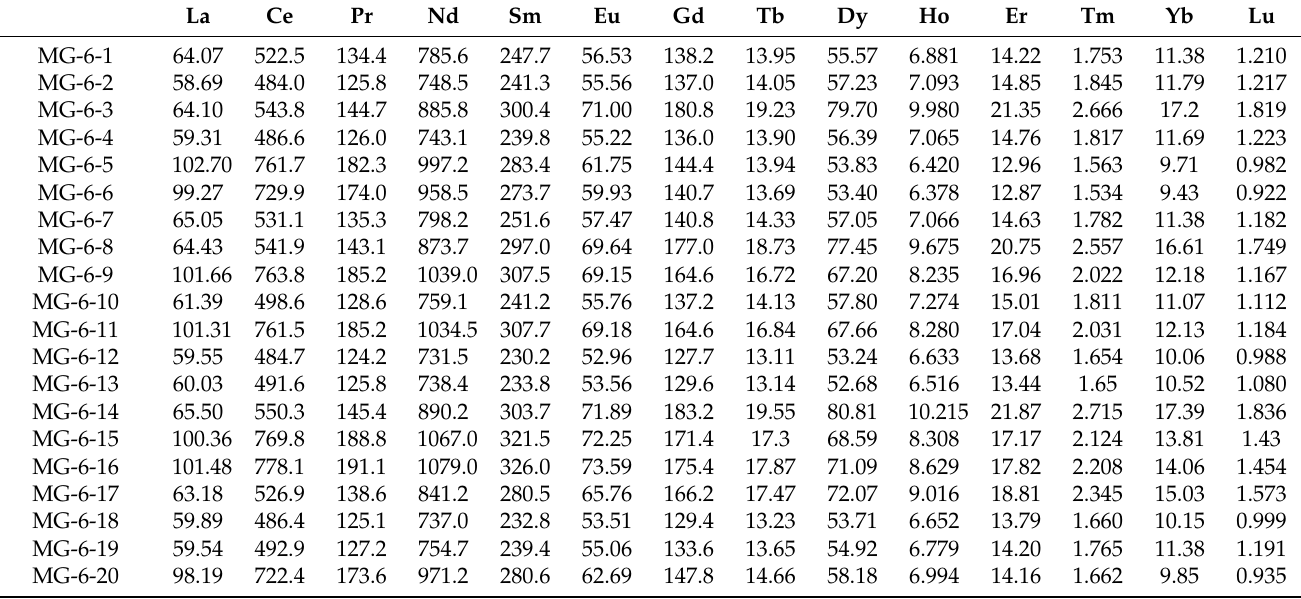
Table 3. Rare earth element content (ppm) of